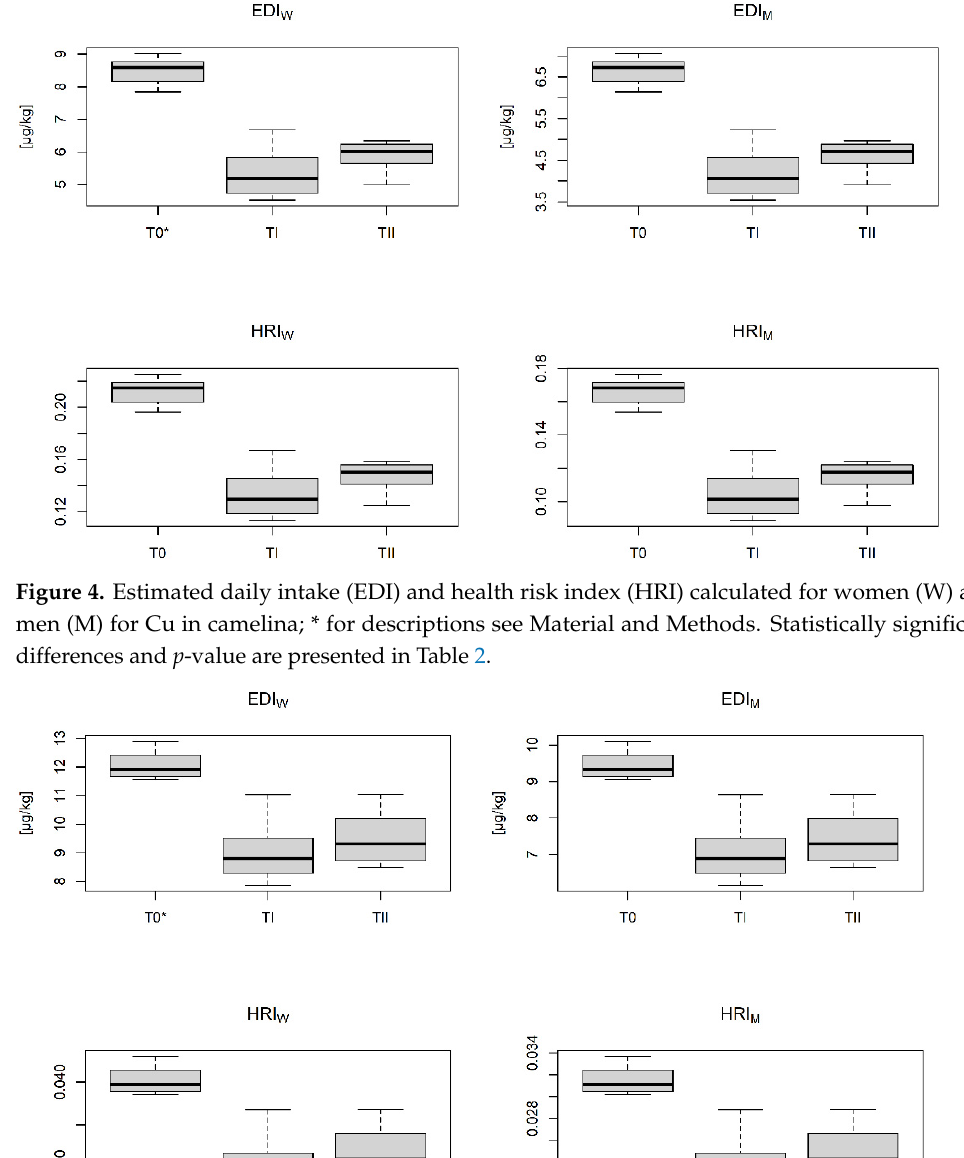
Figure 3. Bioconcentration factors for total (BCF T ) and bioavailable amounts (BCF B ) calculated for Cu and Zn in camelina; * for descriptions see Material and Methods. Statistically significant differ- ences and p -value are presented in Table 2.